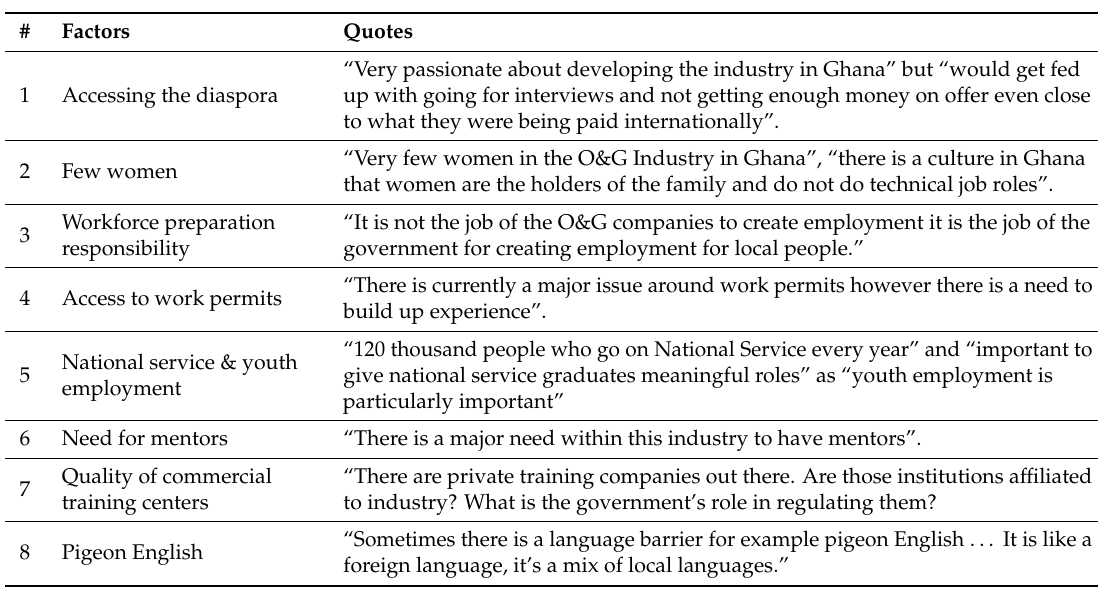
Table 7. ‘Labour market challenges’ theme.